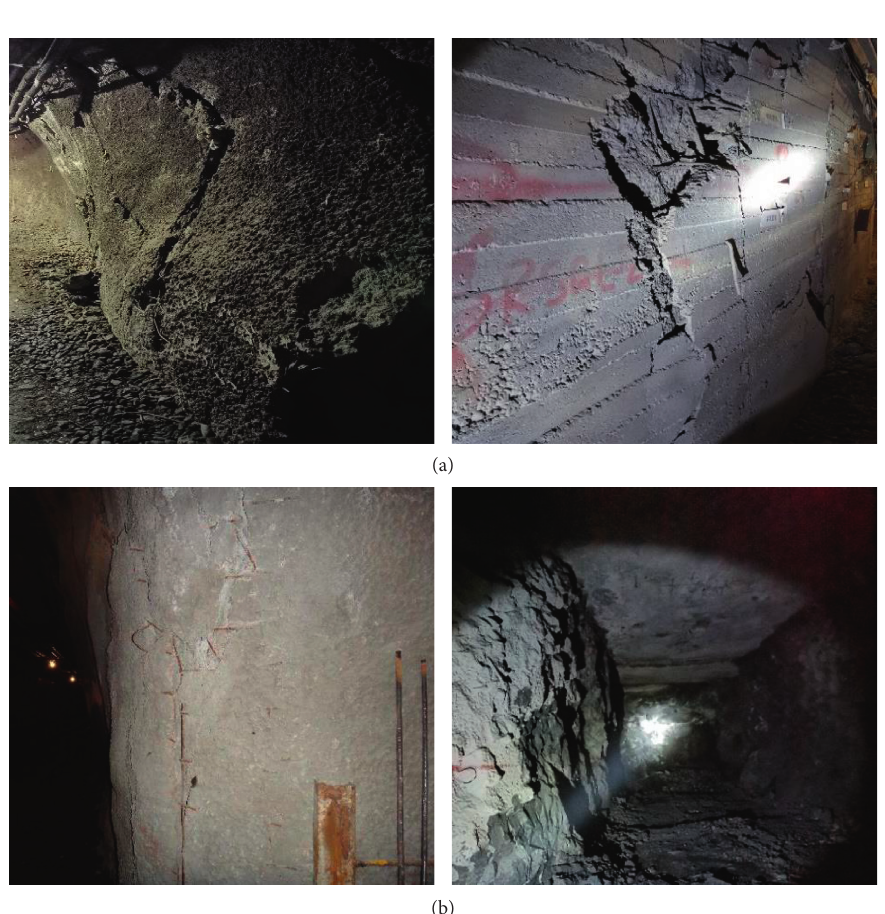
Figure 9: Failure patterns of the roadway (a) before and (b) after the adopted scheme